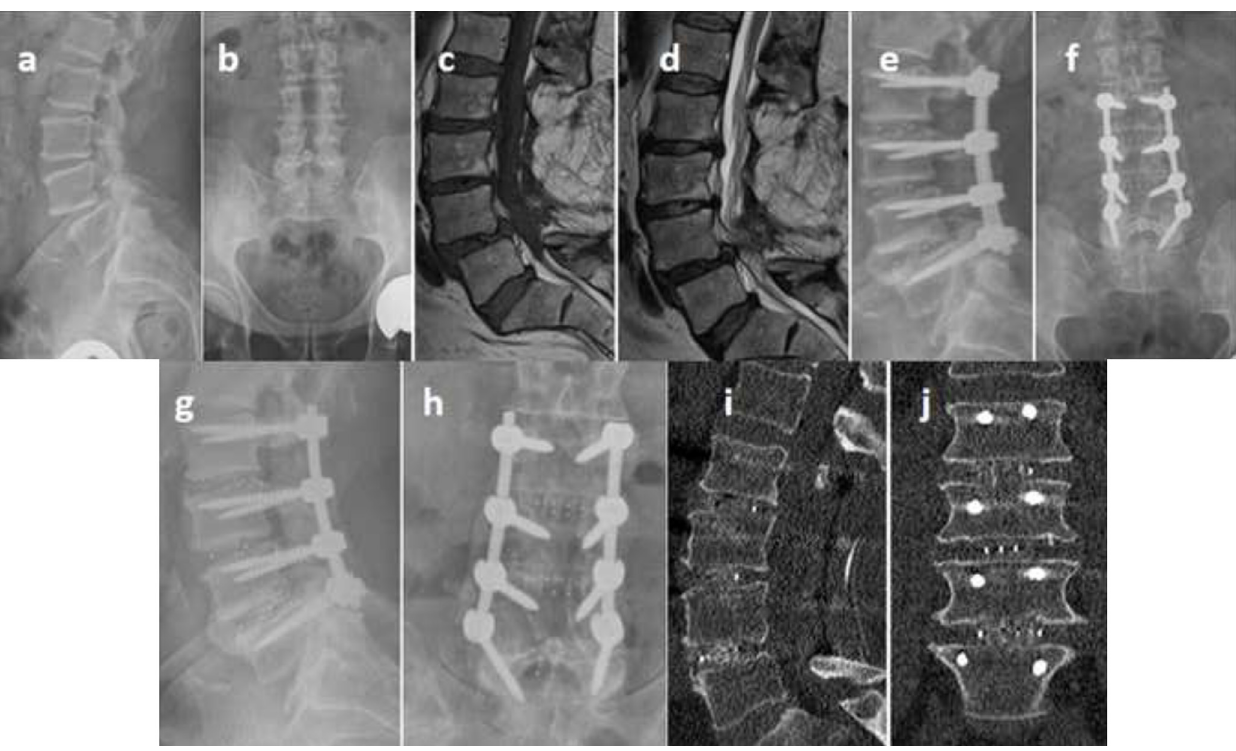
Figure 4. (a – d) Preoperative radiographs and MRI of 68-yrs male with postlaminectomy instability treated with TLIF L2:L5 using modular cages, (e,f) postoperative radiographs, (g – j) bony fusion was achieved at 1 year